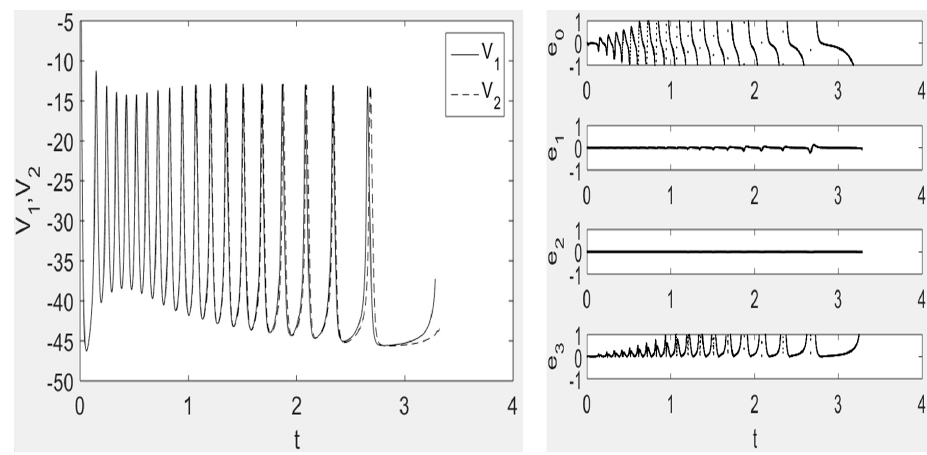
Figure 11. Time histogram and synchronization discrepancy graph when τ = 2.5 and H syn = 2.7. Appl. Sci. 2018 , 8 , x FOR PEER REVIEW